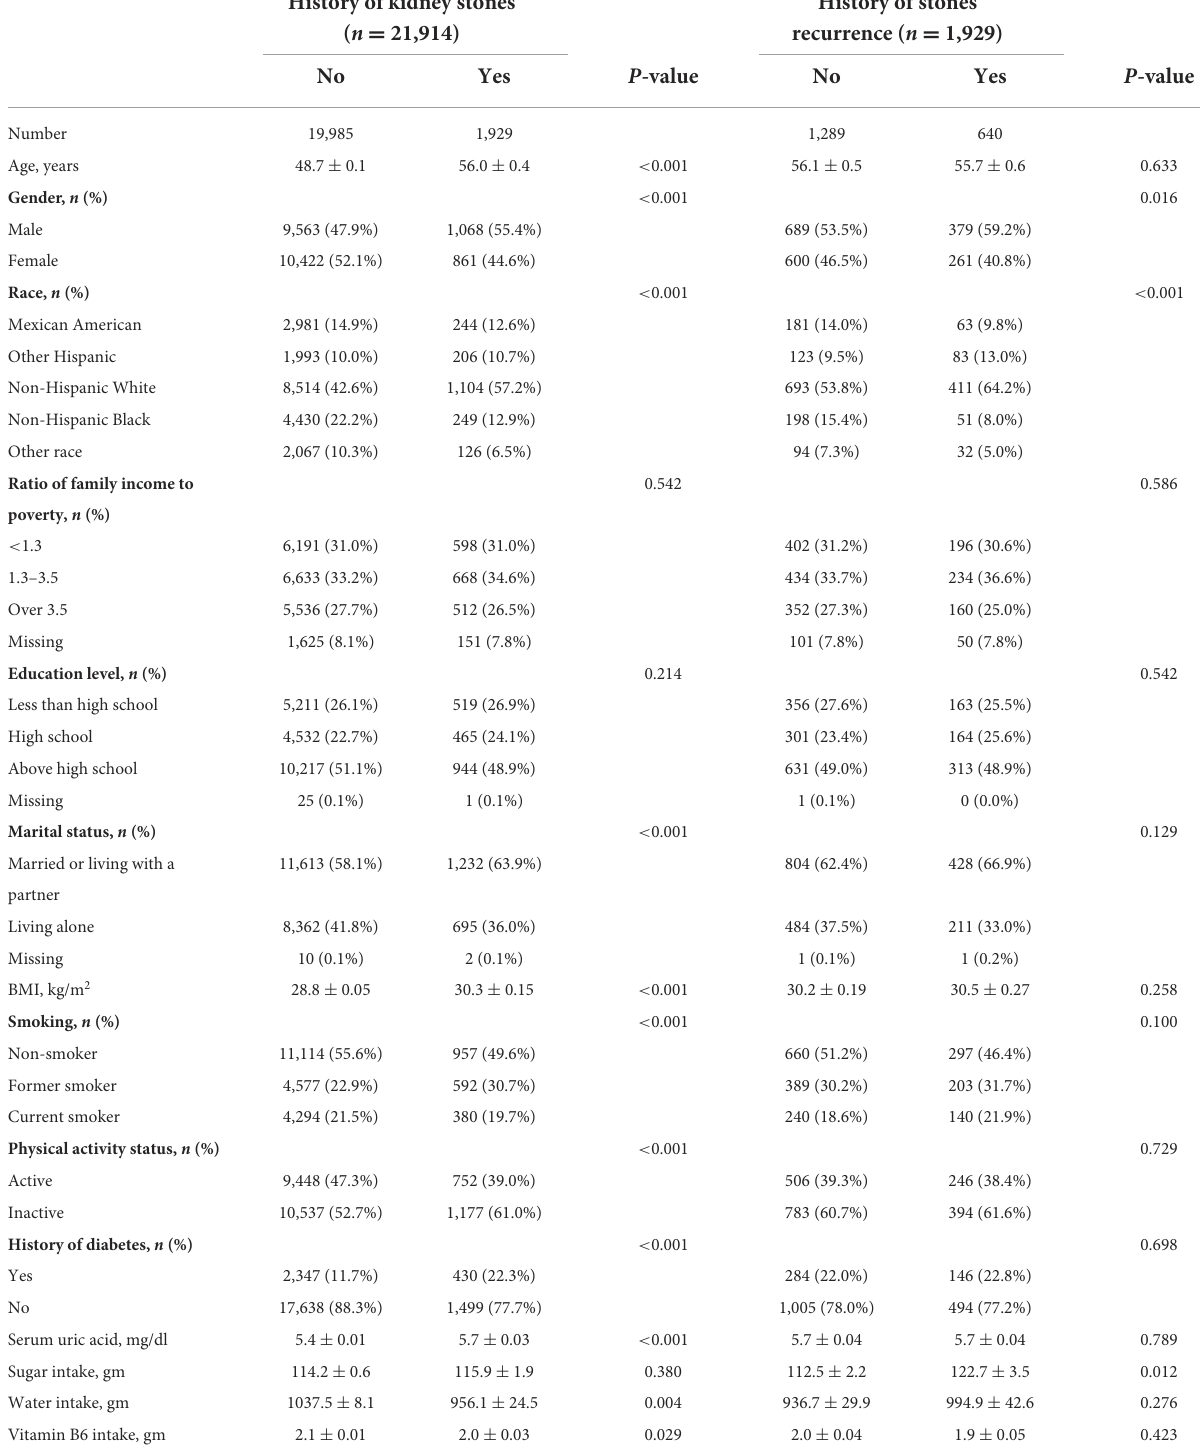
TABLE 2 Baseline characteristics of participants by kidney stones in NHANES 2007–2014. History of kidney stones ( n = 21,914)